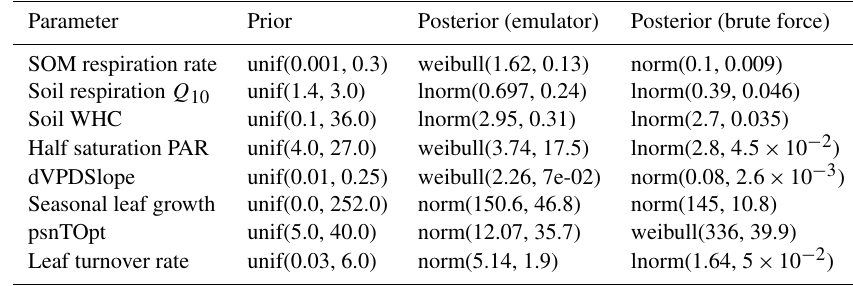
Table A2. The prior and posterior distributions of the constrained SIPNET parameters.